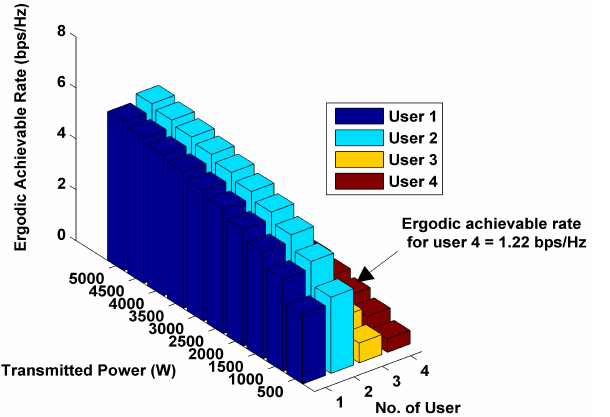
Figure 10. Estimated ergodic achievable rate versus transmitted power in absence of CoMP − JT − based mmWave signal transmission.